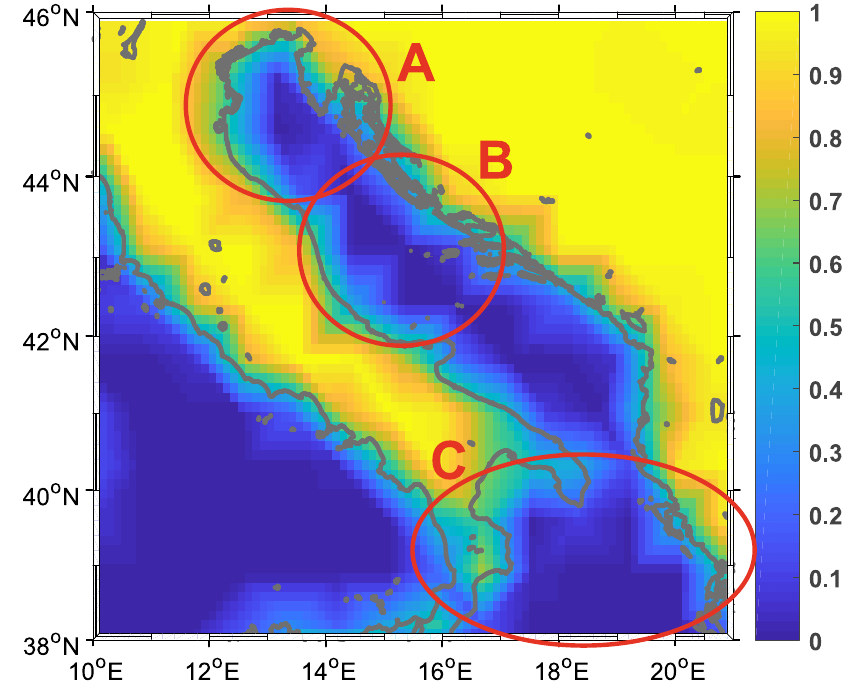
Figure 1. Adriatic sea—the geographic area covered in the study with marked selected zones: ( A ) North Adriatic, ( B ) Middle Adriatic and ( C ) Ionian Sea. Color bar shows wet point index defined by the ERAInterim land-sea